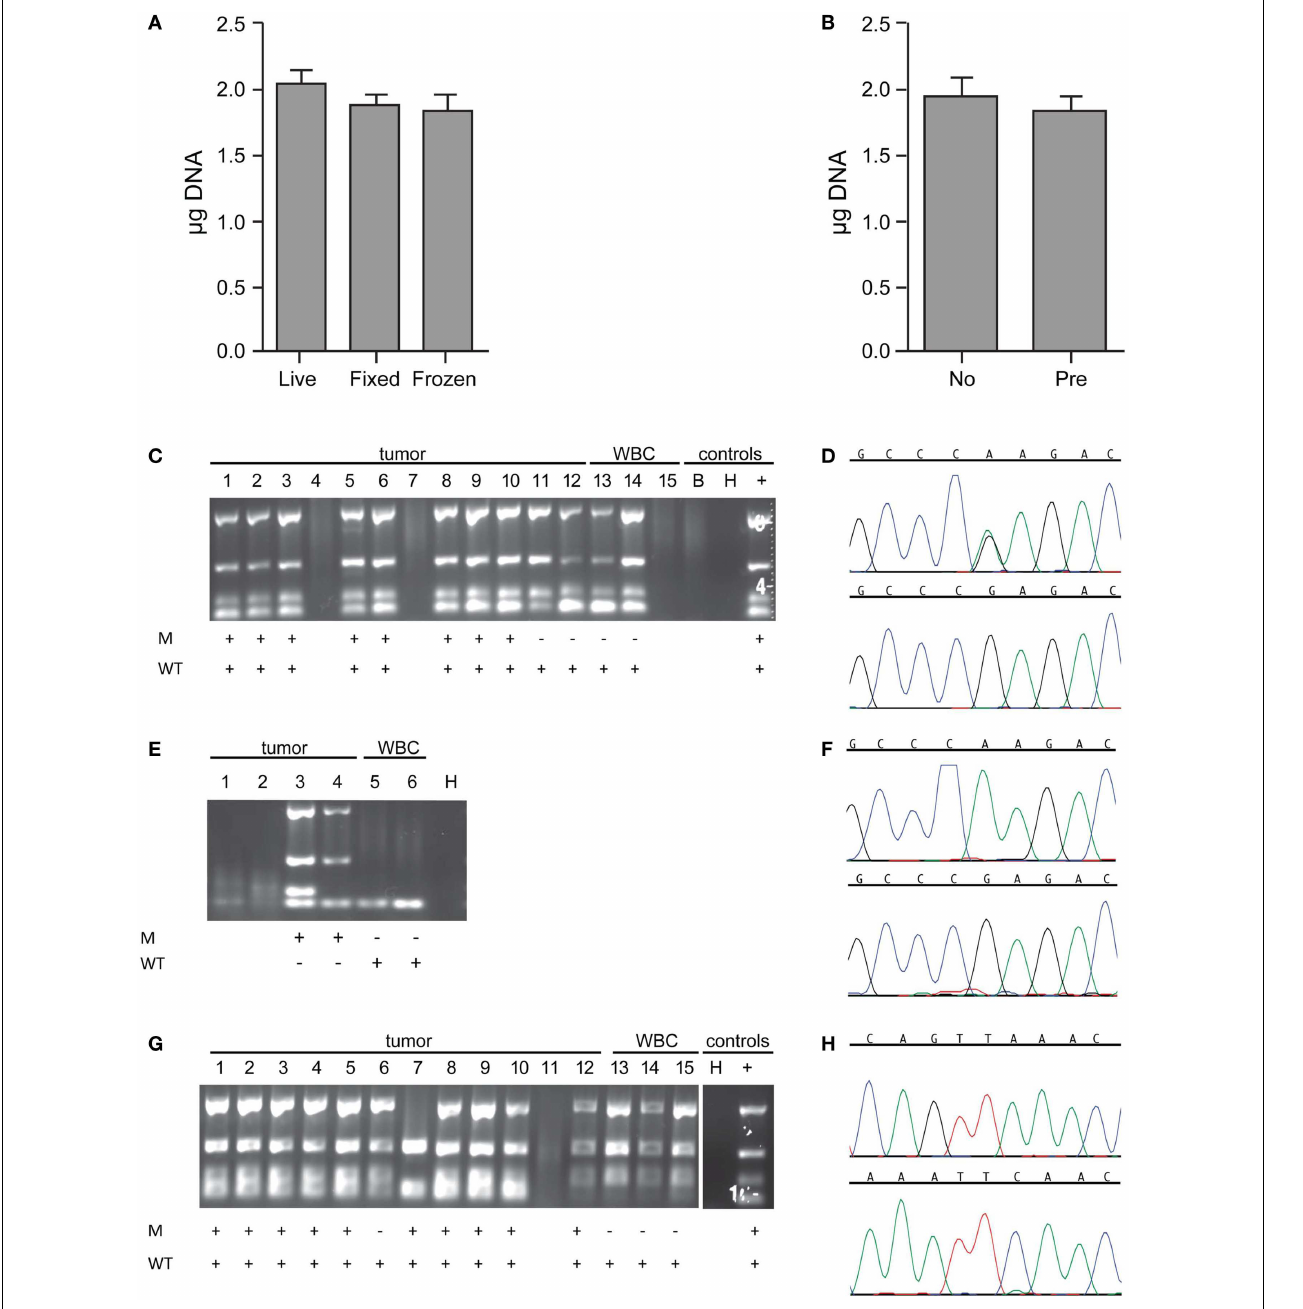
FIGURE 3 |Whole genome amplification and targeted sequencing of single cells . Single cells were isolated by DEPArray, DNA extracted, Ampli1 WGA performed, and the DNA concentration of each sample measured by Picogreen. (A) The meanWGA yield in micrograms of DNA for the 50 µ l elution volume for n = 58 live (unfixed) single cells, n = 95 fixed single cells, and n = 26 frozen/thawed single cells; and (B) n = 40 single cells from unenriched samples (left bar) and n = 55 single cells (right bar) from samples that had been pre-enriched by flow sorting prior to single cell capture on the DEPArray. Included in this analysis are single cells isolated from spiked cell lines as well as patient samples described in the text. For the data shown in (B) , all cells were fixed. (C) A 1:10 mix of NB1643 cells andWBCs was